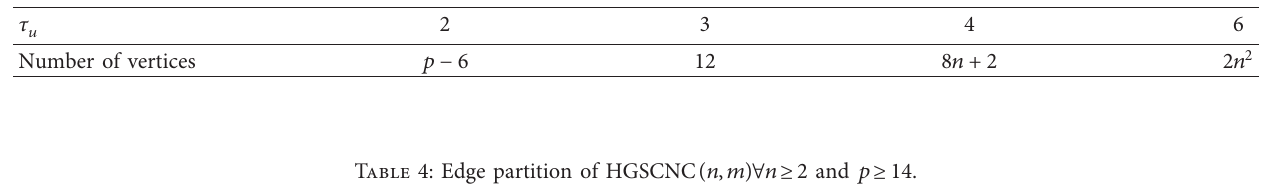
Table 3: Vertex partition of HGSCNC ( n,p ) ∀ n ≥ 2 and p ≥ 10.